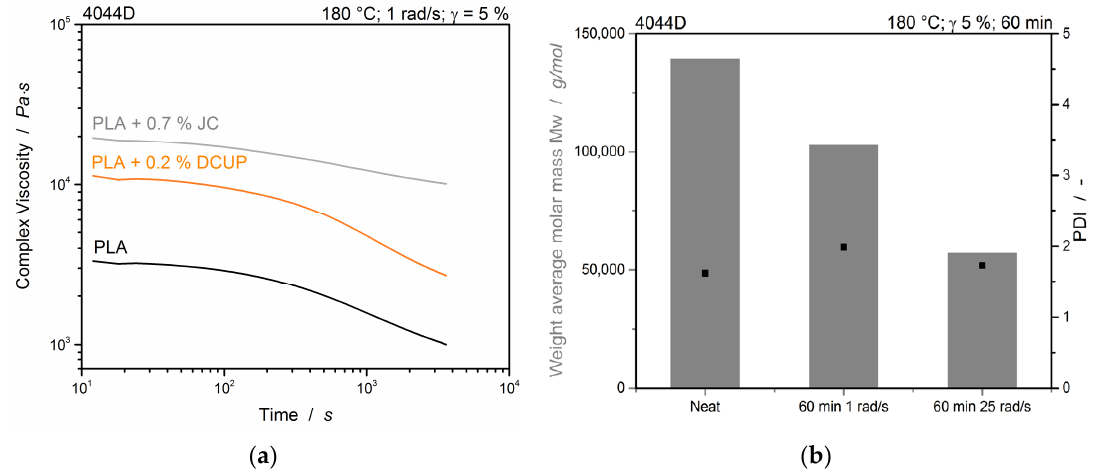
Figure 2. ( a ) Time sweeps and ( b ) The weight average molar mass M w and polydispersity (PDI) before and after the time sweep tested with different frequencies.